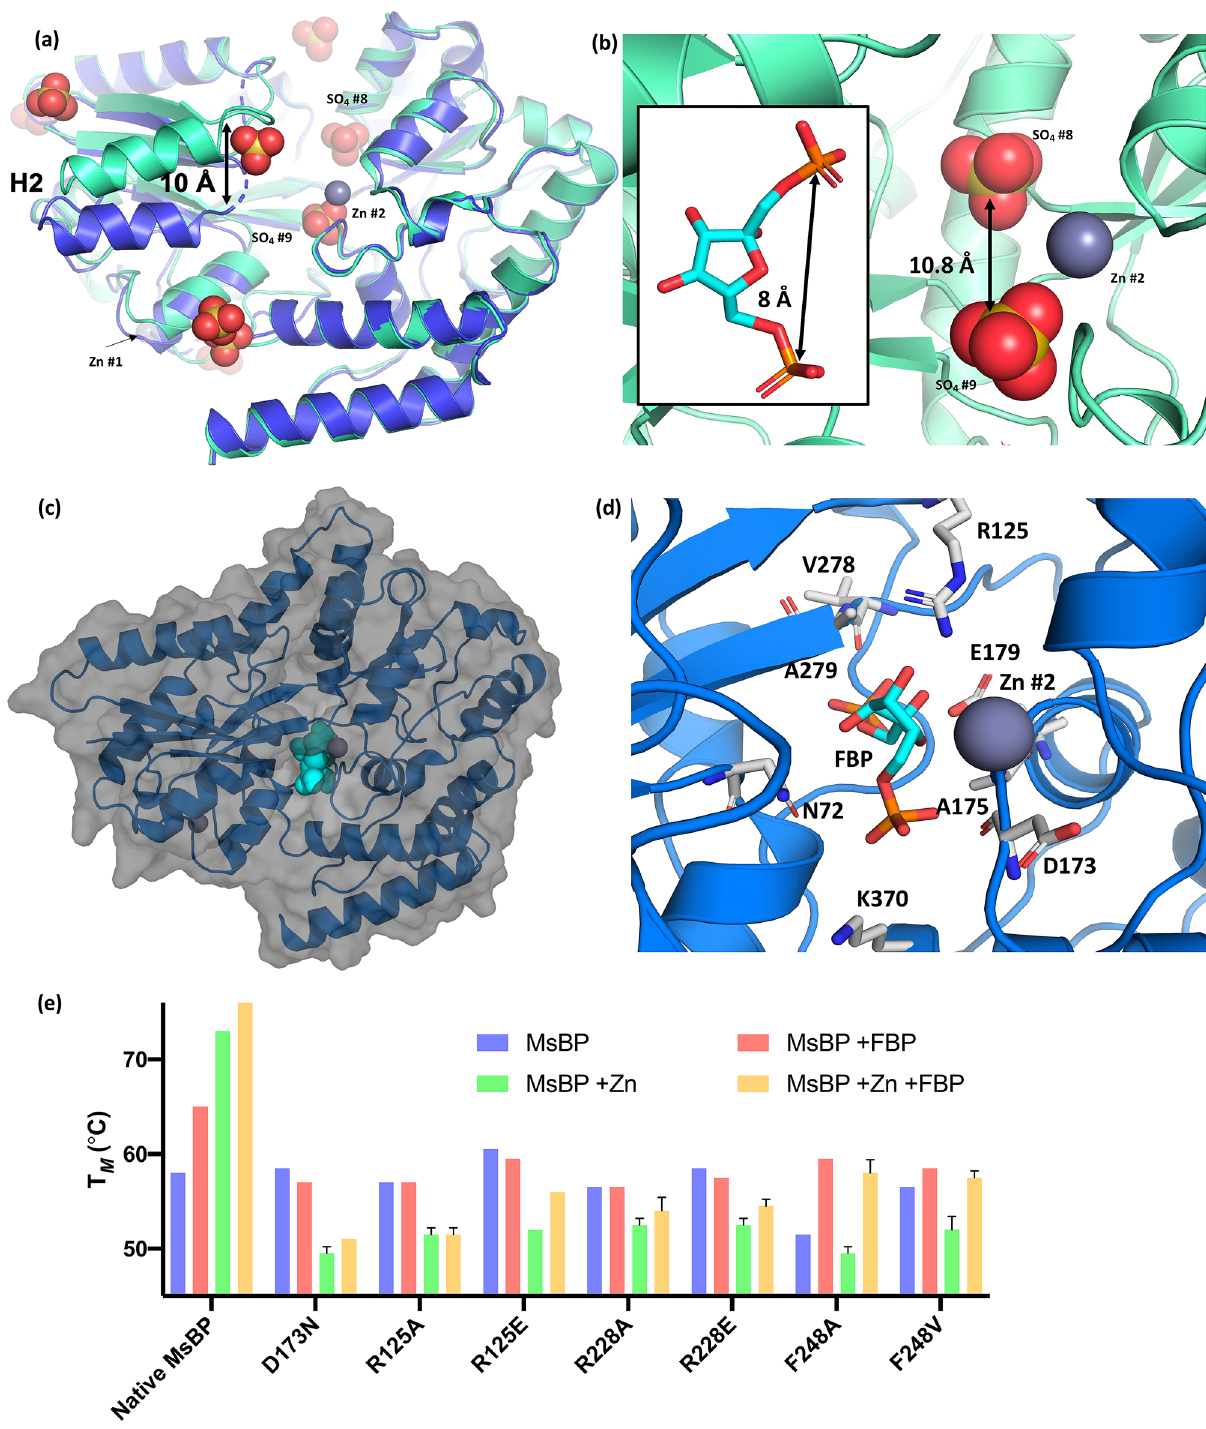
Figure 4. The ligand binding cleft of MsBP. (a) depicts an overlay of Zn-MsBP (aqua) and unbound MsBP (blue, r.m.s.d. 0.873 Å) highlighting structural difference caused by movement of helix 2 (10 Å) in the presence of zinc. Key Zn (grey) and sulphate (red) ions are indicated. (b) highlights the modelled distance between key sulphate ions captured within the binding cleft of Zn-MsBP with (inset) the distance between cognate sulphate ions for fructose-1,6-bisphosphate (PDB ligand code FBP). (c) Best FBP conformer docked in the binding cavity of Zn-MsBP using AutoDock Vina 66 . (d) Zoomed view of FBP conformer with best fit (autodock ligand fit number 1) localised at SO 42− #9 site within the Zn-MsBP binding cleft, showing predicted phosphate positioning with putative binding residues indicated. (e) Thermal melt analysis of MsBP mutants. MsBP melting temperature (violet), as well as in the presence of FBP (red), Zn (green), or FBP + Zn (yellow), are indicated for native MsBP protein and single-site mutants that correspond to the predicted binding residues identified from the docked FBP